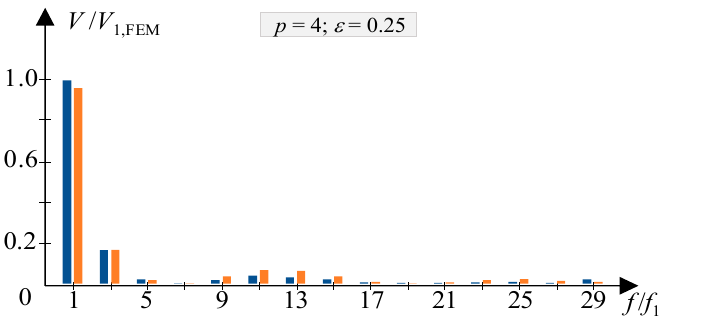
Figure 11. Armature voltages in rated load conditions at steady state; ( a ) results of FEM analysis; ( b ) results from theoretical model.